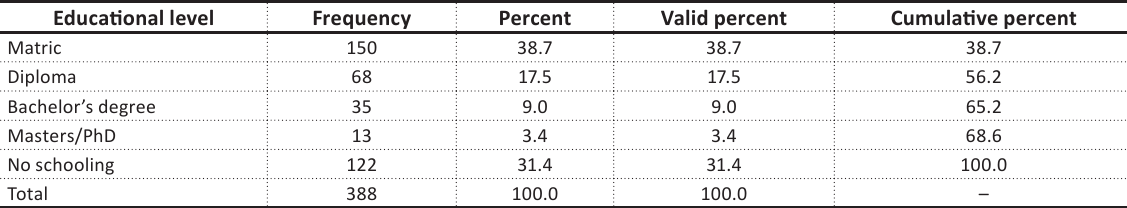
Table 7. Response on educational level of stokvel